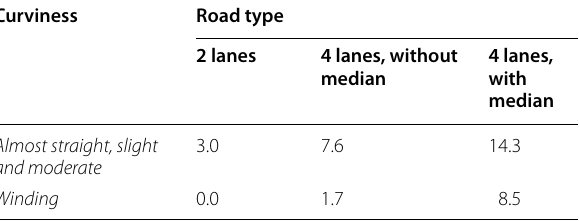
Table 1 Overall benefits of a four-lane road (cent/km per vehicle), rural strategic highways (relative to a winding two-lane road), based on Hensher and Sullivan